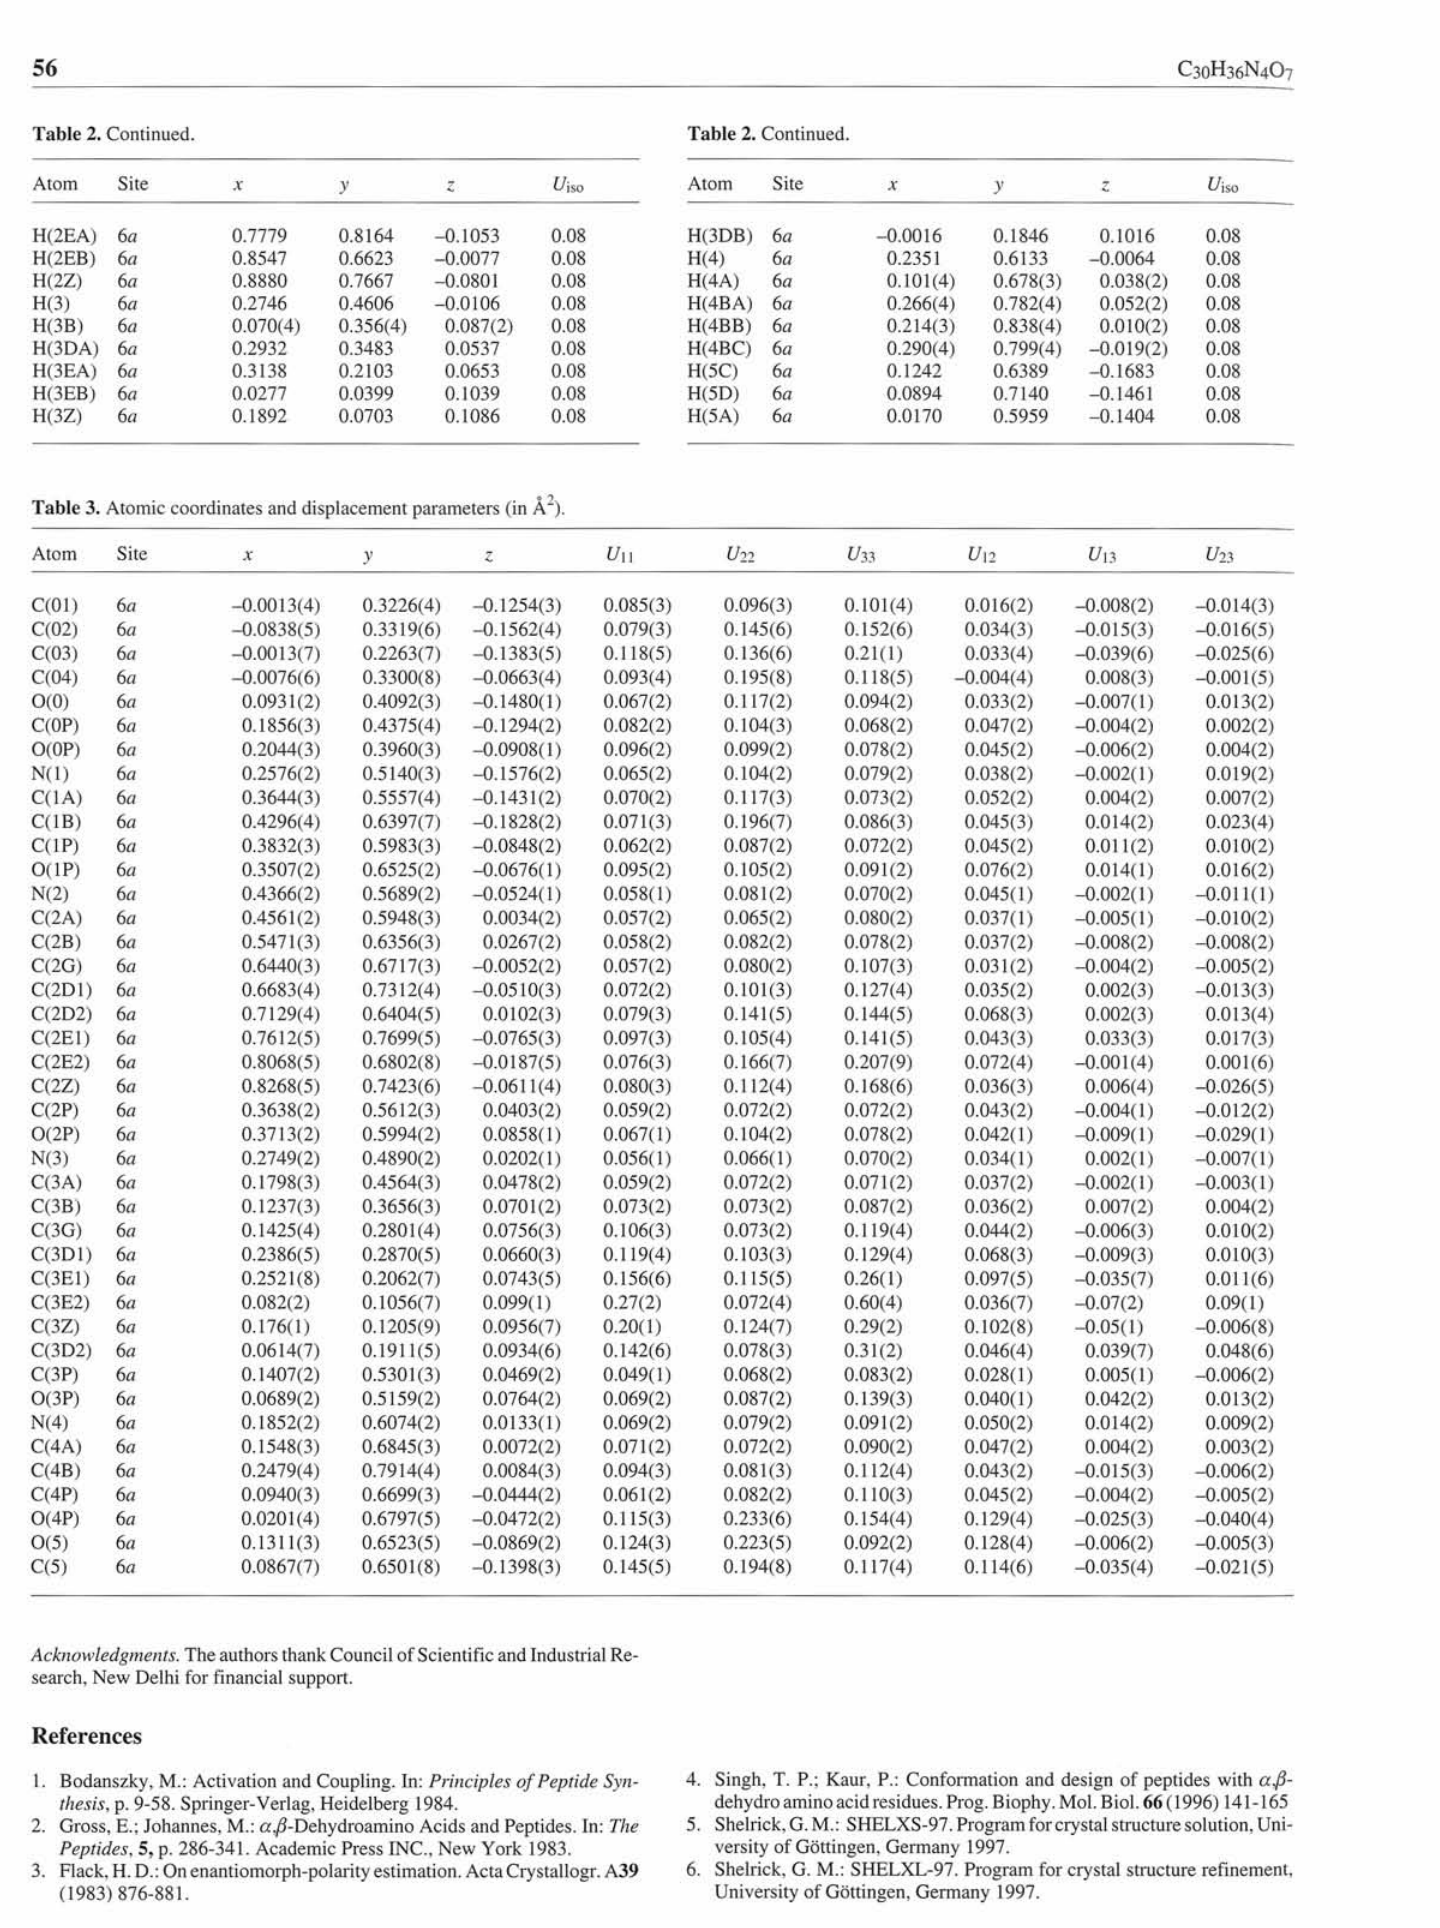
Table 3. Atomic coordinates and displacement parameters (in À 1